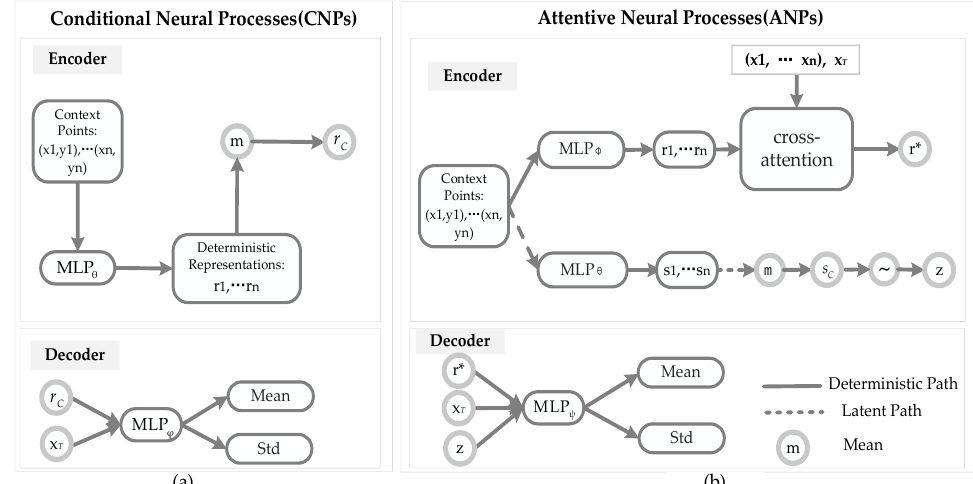
Figure 2. Architectures of CNPs and ANPs. ( a ) Components of a CNP model: the encoder of CNPs is composed of a deterministic path to generate a representation r ; the decoder of CNPs uses the r and target x T to produce the mean and the Std. ( b ) Components of an ANP model: the encoder of ANPs is composed of a deterministic path to generate a representation r ∗ and a latent path to generate latent variable z ; the decoder of ANPs uses the r ∗ , z , and target x T to produce the mean and the Std.